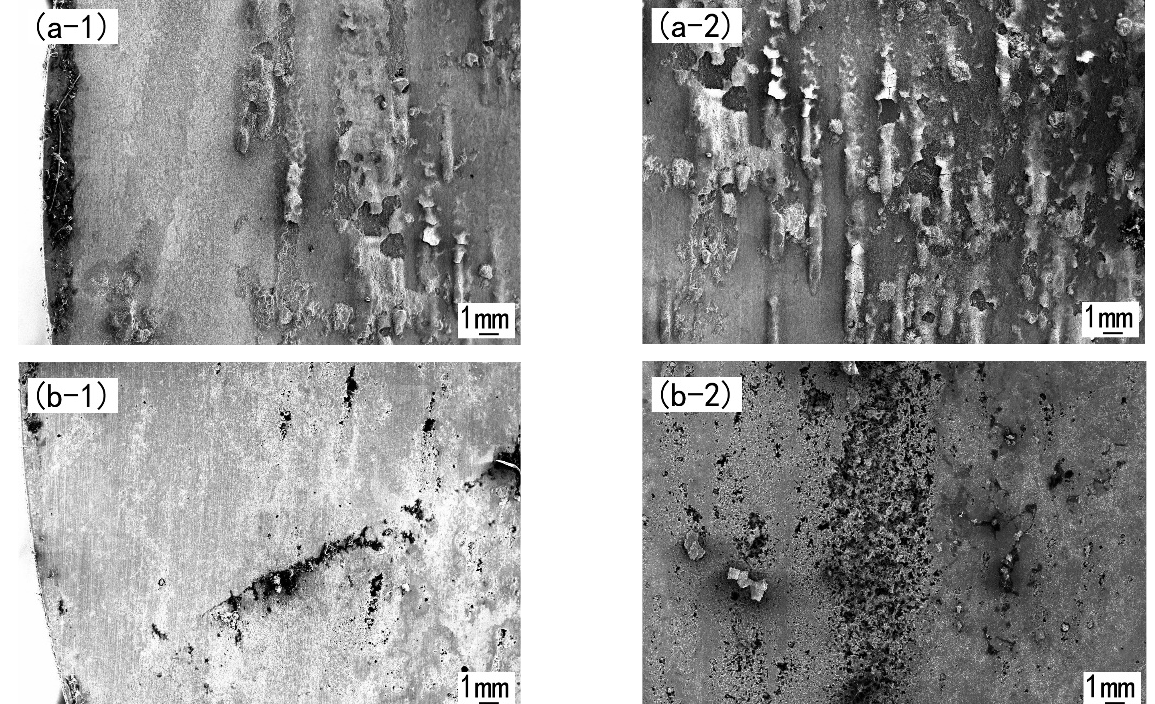
Figure 11. Surface topography of the erosion-corrosion test electrode: ( a ) before chemical cleaning, ( b ) after chemical cleaning.